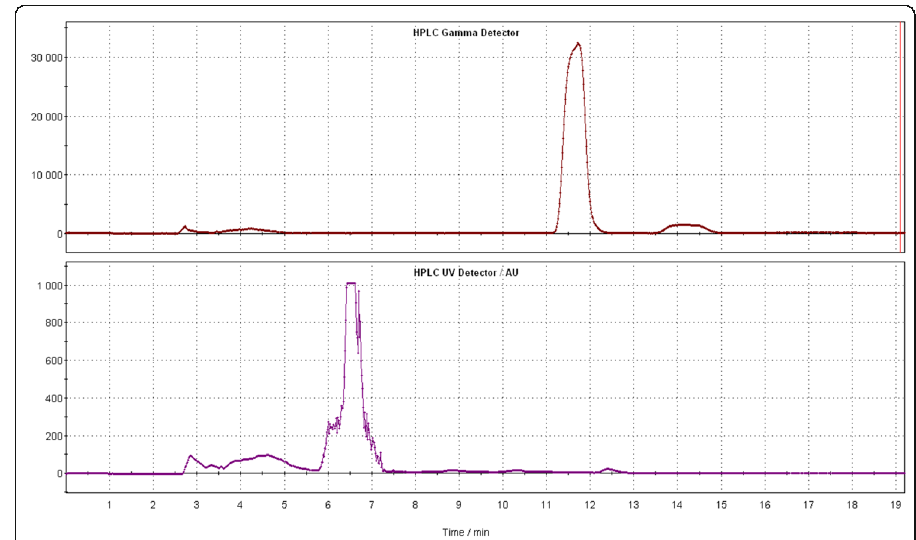
Fig. 3 Chromatograms of semi-preparative HPLC [ 18 F]LBT999 purification on TRACERlab FXFN modules (Gamma and UV). Alltima C18 column (250 X 10 mm, 5 μ m, Grace, Alltech, France) by using as mobile